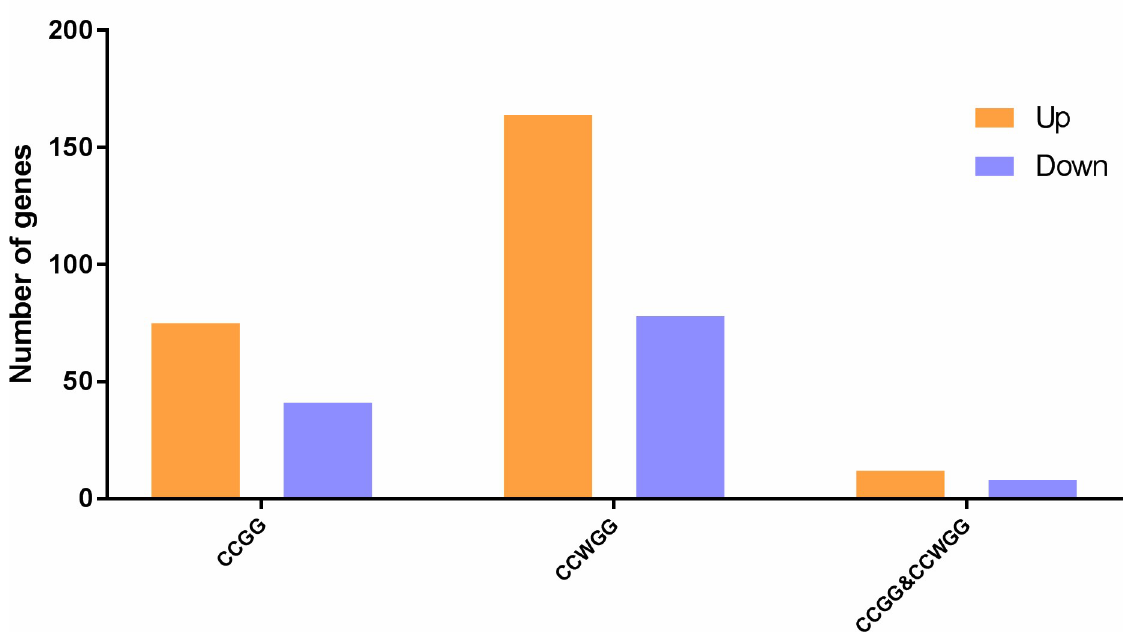
Fig 4. Gene statistics of different methylation levels.